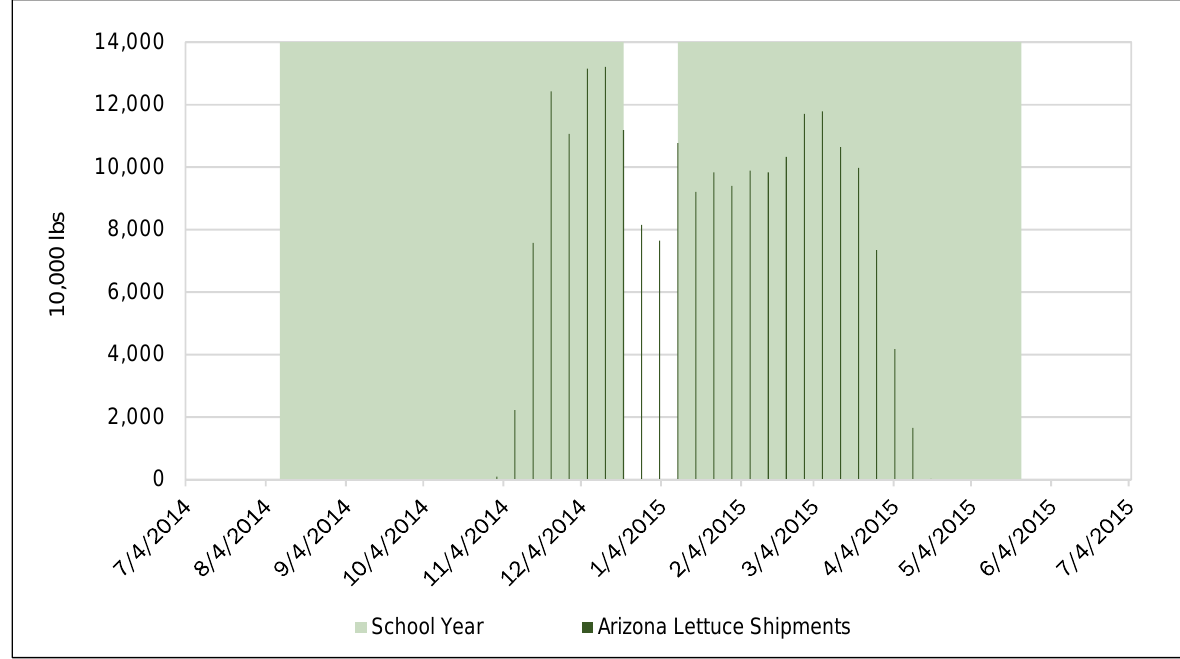
Note: 1 lb.= 0.45 kg Sources: USDA AMS Specialty Crop Shipment Data & Tucson Unified School District academic